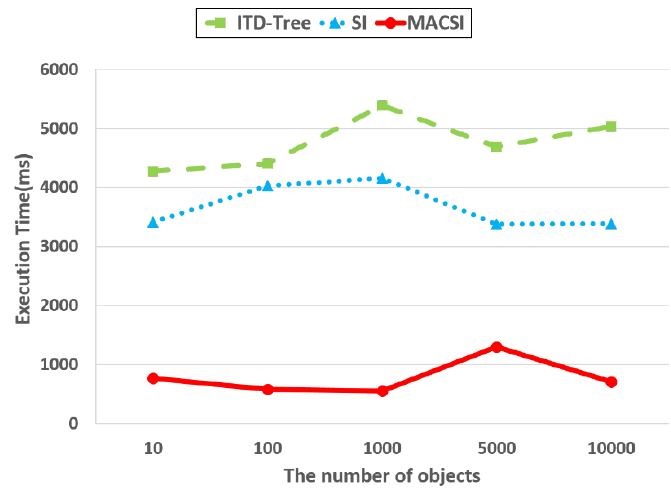
Figure 19. The effect of object number on fine-grained semantic cell query.